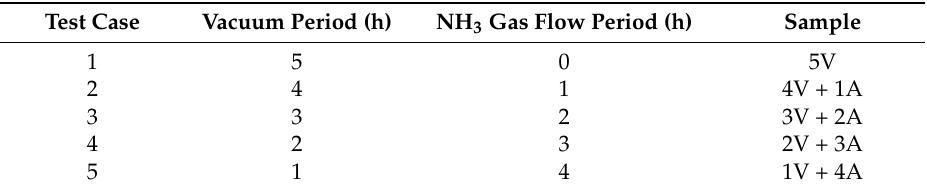
Table 1. Milling time conditions (V = Vacuum and A = Ammonia gas